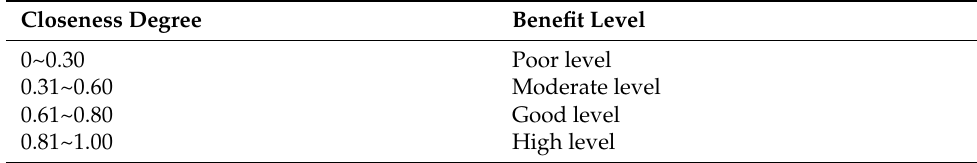
Table 2. Cultivated land-use benefit evaluation criteria. Closeness